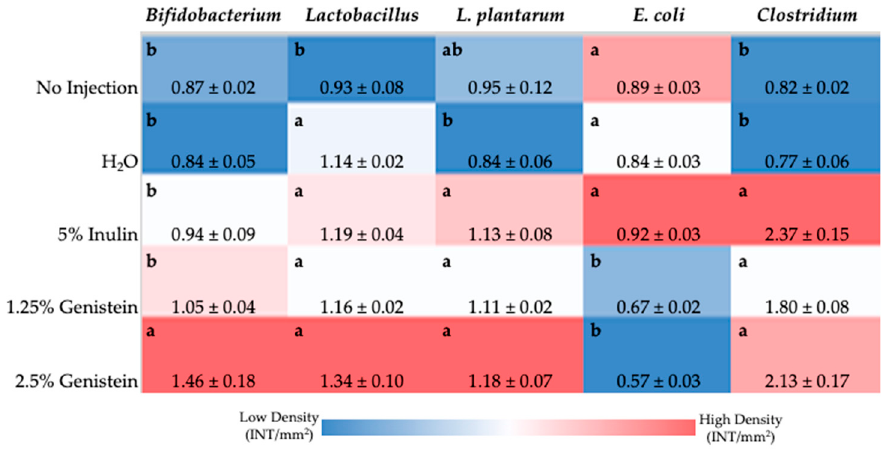
Figure 2. Effects of intraamniotic injections of genistein and the controls on duodenal genera and species-level bacterial populations. Values are presented as mean ± SEM, n = 5, as relative intensity of bands per mm 2 of gel. a,b per bacterial category (in the same column), treatment groups that do not share any letters are significantly different ( p < 0.05) according to one-way ANOVA with post-hoc Duncan